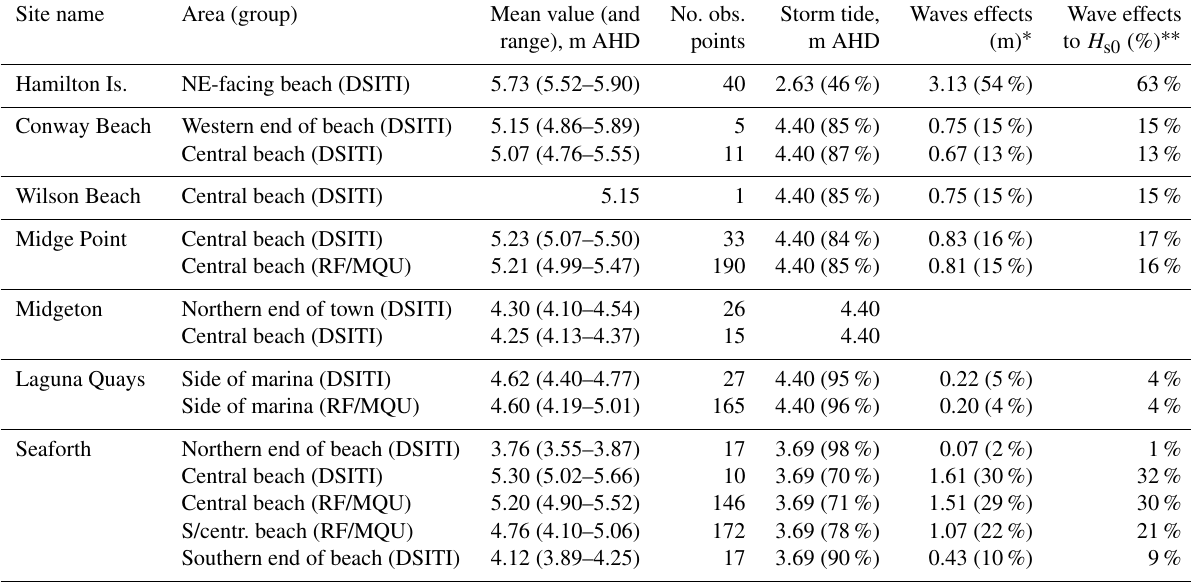
Table 4. Maximum limits of inundation during Debbie , from field surveys (north to south) by RF/MQU and DSITI. Storm tide height is the maximum recorded at Shute Harbour gauge for Hamilton Island, Mackay gauge for Seaforth and Laguna Quays gauge for all others. Shute Harbour is probably not a good representation of the storm tide level at Hamilton Island, but was the closest gauge during Debbie . Additional sites were surveyed by DSITI and are detailed in DSITI (2017).